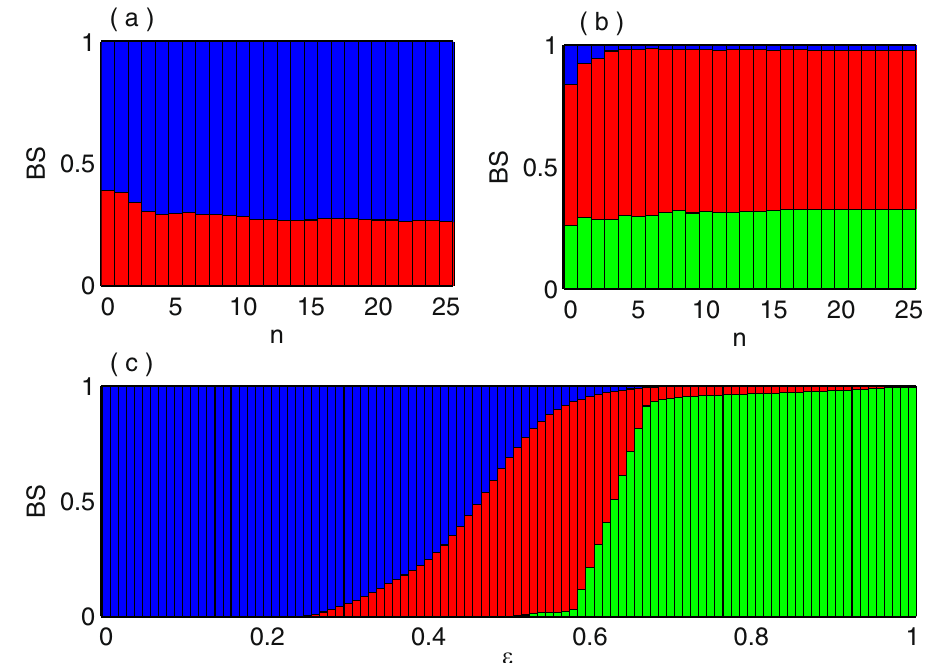
Figure 5. Basin stability analysis for nonlocally coupled Mackey-Glass systems: ( a ) and ( b ) show the fluctuation of basin stability with respect to the degree of polynomial basis for = . 0 4  and  = . 0 625 . ( c ) The variation of BS of incoherent, chimera and coherent states with respect to the coupling strength  . Blue, red and green colors respectively represent the incoherent, chimera and coherent states.